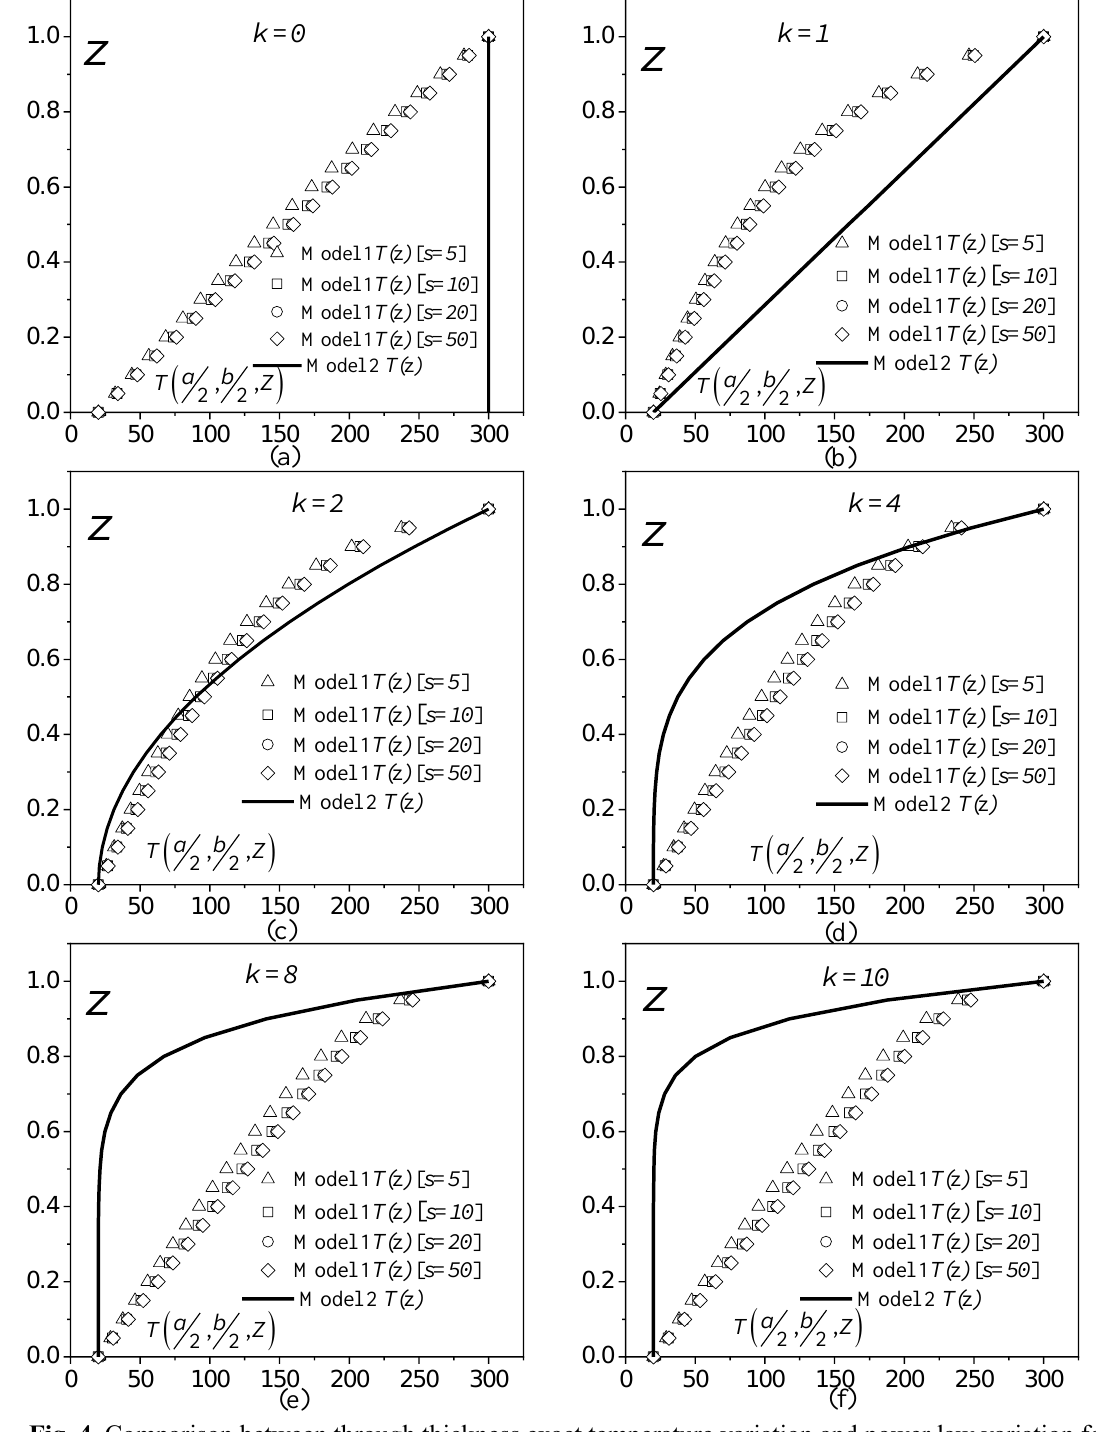
Fig. 4. Comparison between through thickness exact temperature variation and power law variation for different power index ( k) for square laminate material set